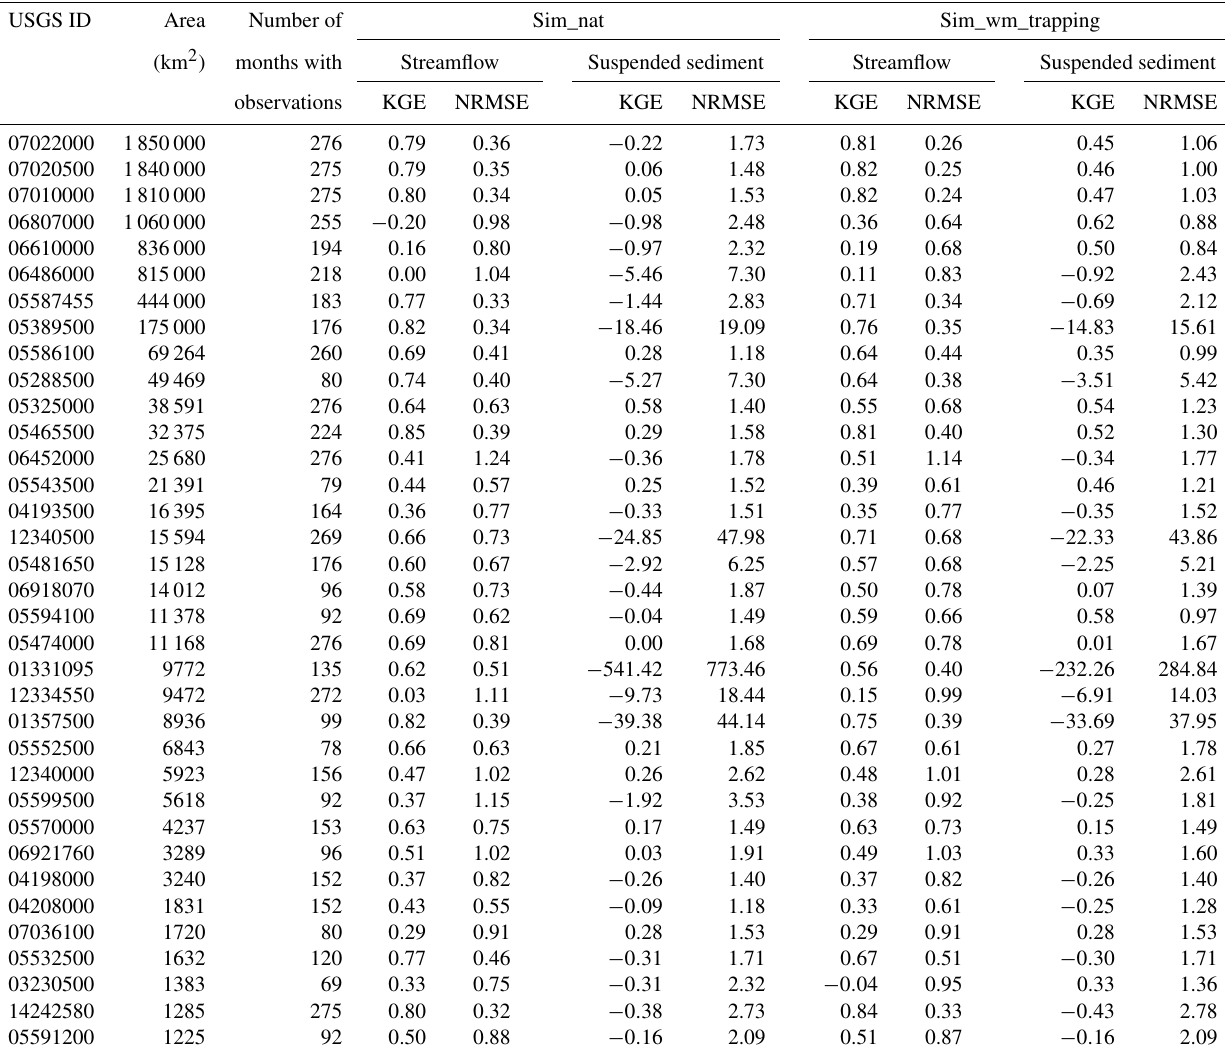
Table 1. List of selected USGS gauges and model performance. USGS